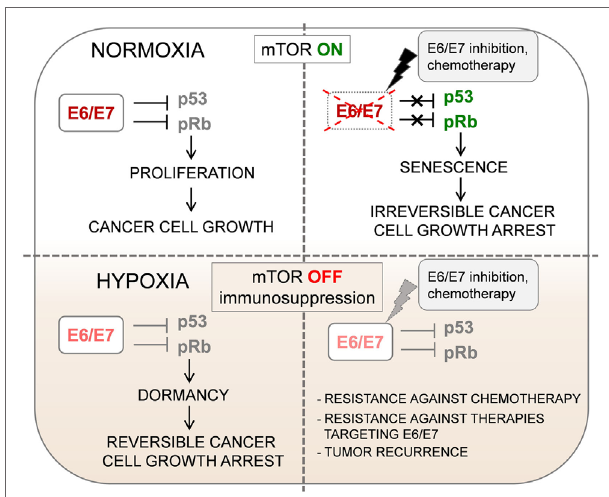
FIGUre 1 | Oxygenation can change the biological behavior of HPV-positive tumors. Impaired mechanistic target of rapamycin (mTOR) signaling and concomitant HPV E6/E7 repression in hypoxic HPV- positive cancer cells allow the evasion of senescence. This has several clinical implications for the treatment of HPV-associated cancers: (1) dormant HPV-positive cancer cells in hypoxic subregions of tumors might lead to cancer recurrence if oxygen supply increases; (2) the growth inhibition under hypoxic conditions in cancer tissues results in increased therapeutic resistance against pro-senescent chemotherapeutic agents; (3) reduced expression of viral E6/E7 oncoproteins could represent a major obstacle for immunotherapy of HPV-associated